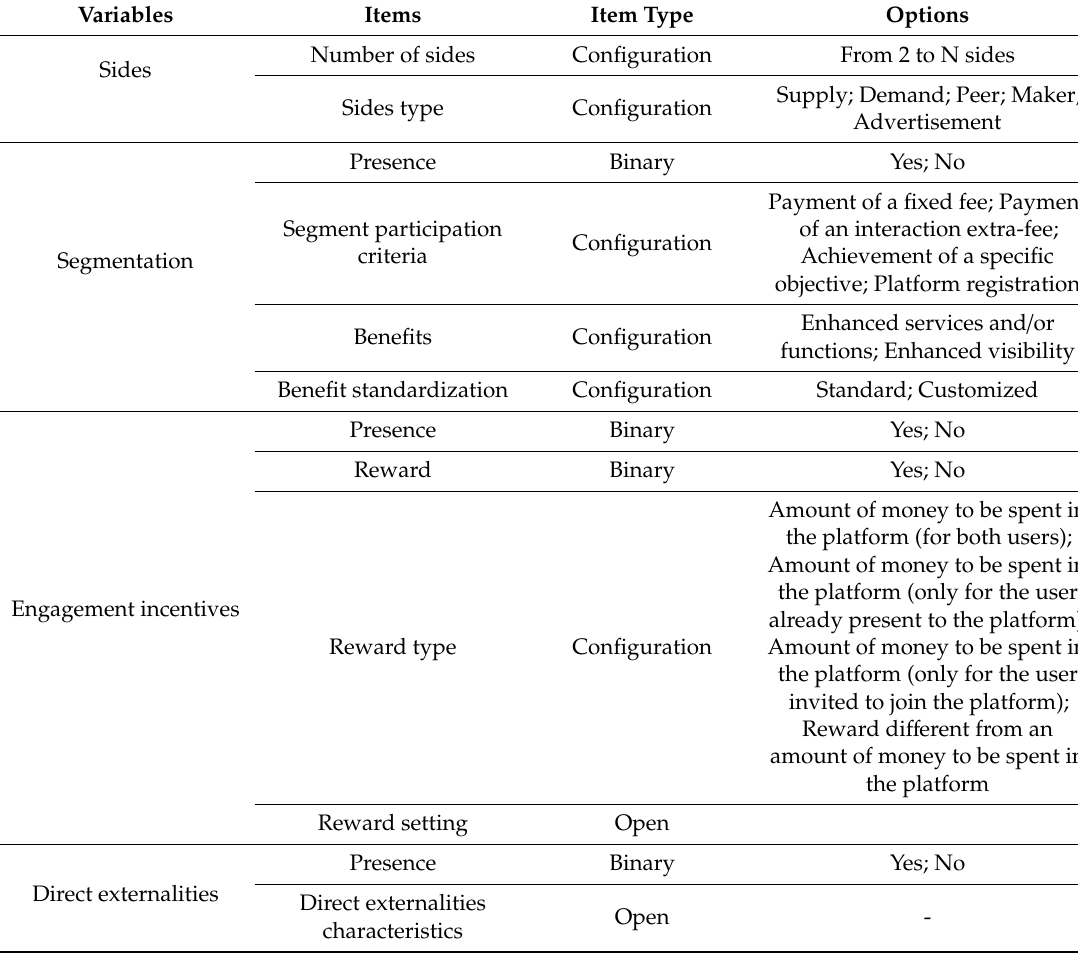
Table 6. Variables, items and configuration options for the “platform sides”